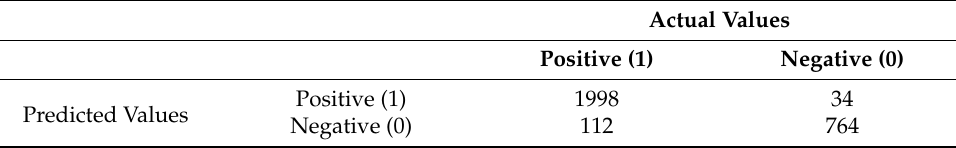
Table 11. Naive Bayes confusion